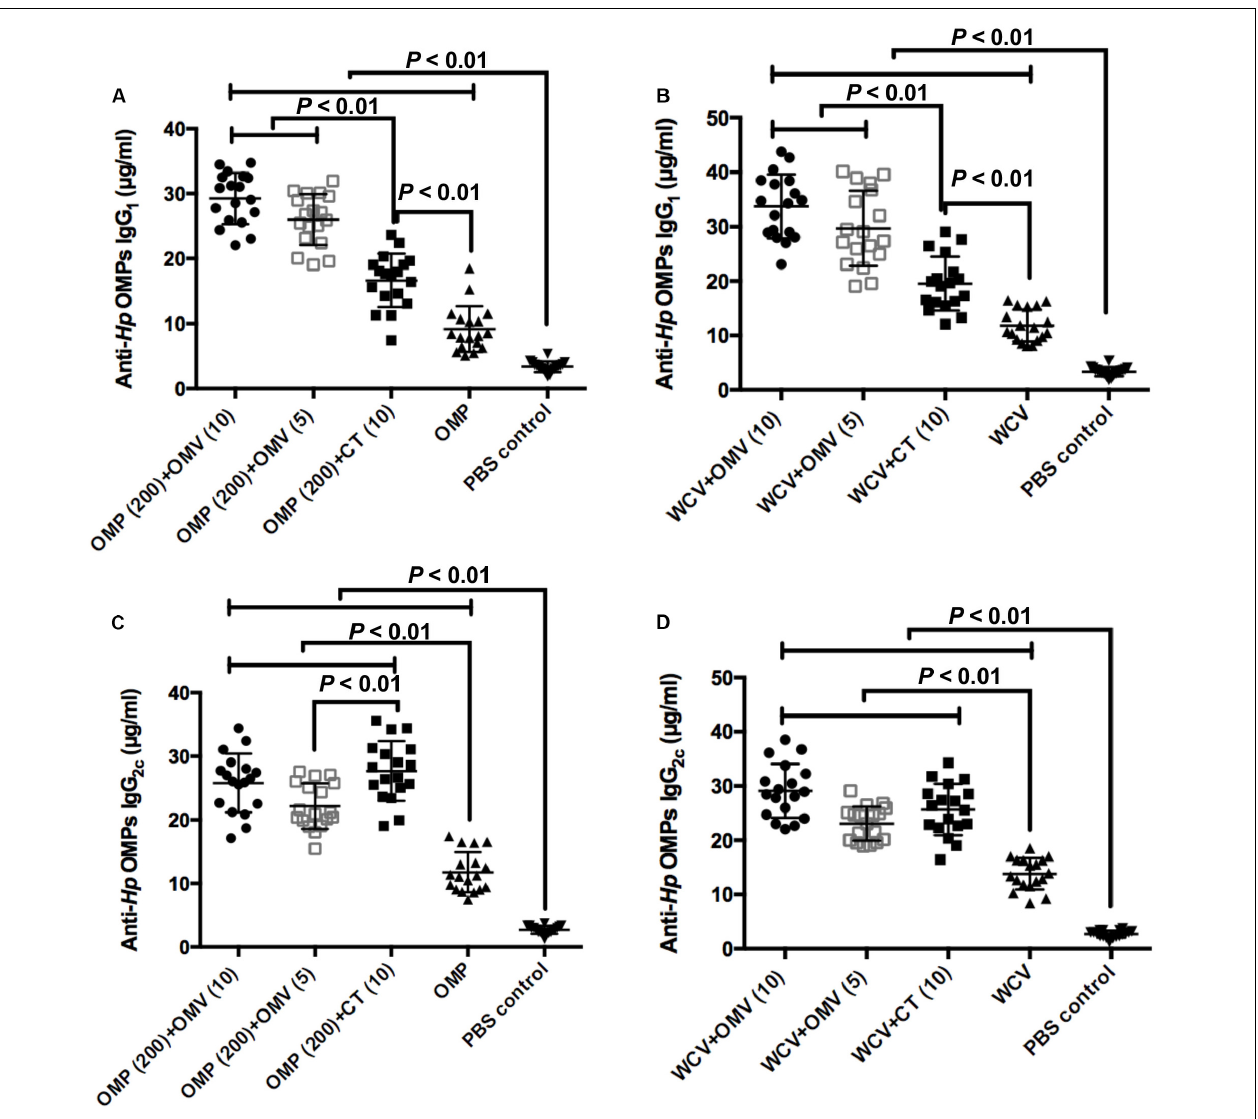
FIGURE 5 | The concentrations of anti- Hp IgG 1 of groups used OMP (A) or WCV (C) as vaccine, and the levels of anti- Hp IgG 2c of groups with OMP (B) or WCV (D) were determined by ELISA against OMPs isolated from H. pylori . Each group was comprised of 18 mice. The exact concentration of IgG 1 and IgG 2c subclass antibodies in serum samples of mice at 8 weeks after immunization are shown. The means were compared using the least significant difference test. P < 0.01 reflect statistical significance between the related